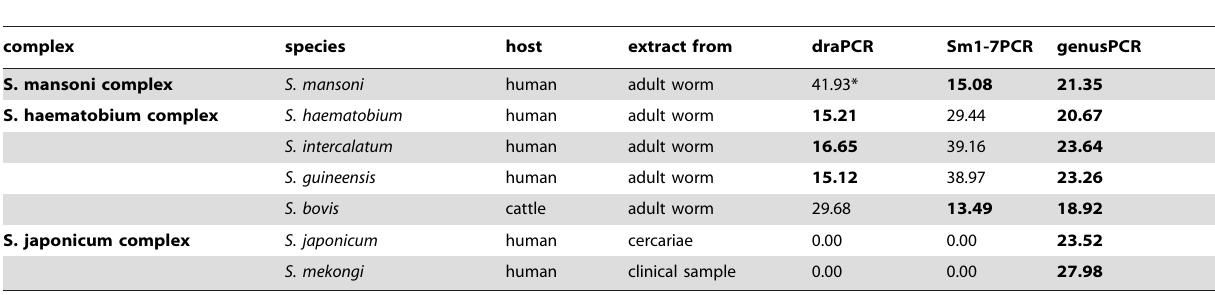
Table 1. Species-specificity of the draPCR in comparison to the Sm1-7PCR and the genusPCR.